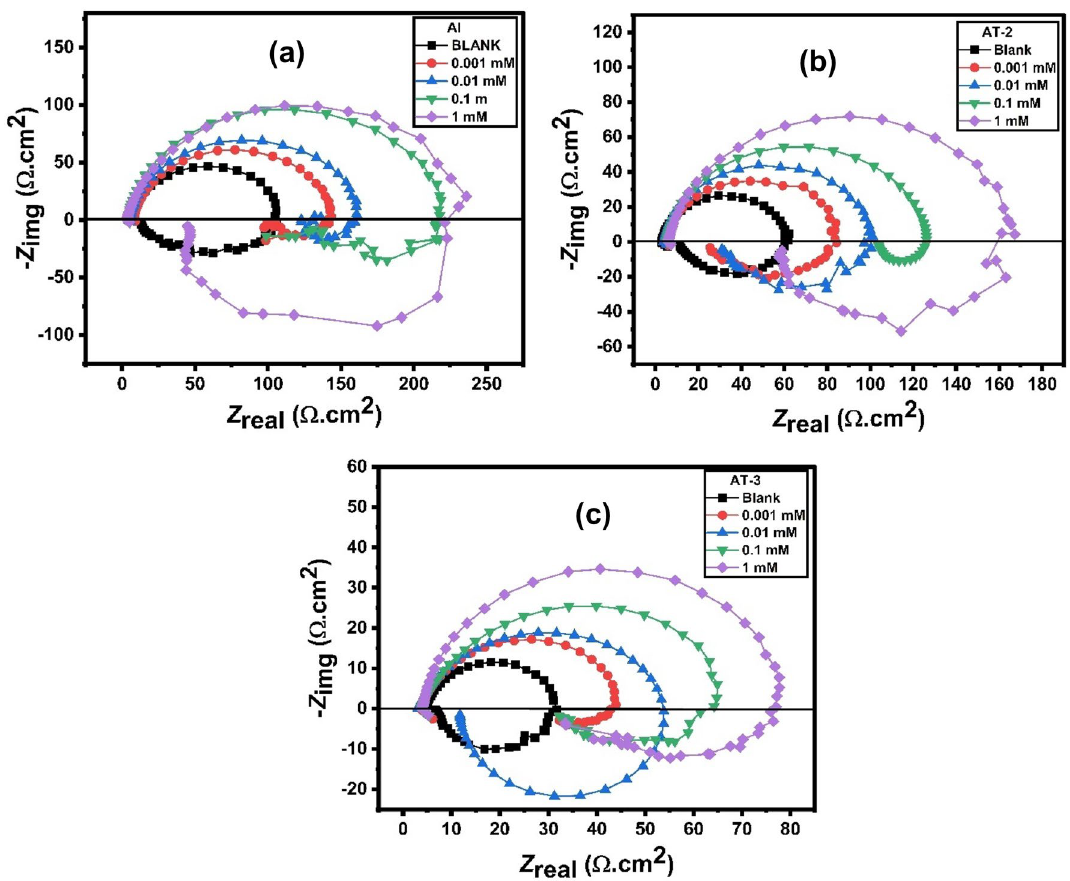
Figure 12. Nyquist plots for ( a ) Al, ( b ) AT-2 alloy and ( c ) AT-3 alloy in 0.5 M HCl comprising different concentrations of 2-MBT inhibitor at 25 °C.